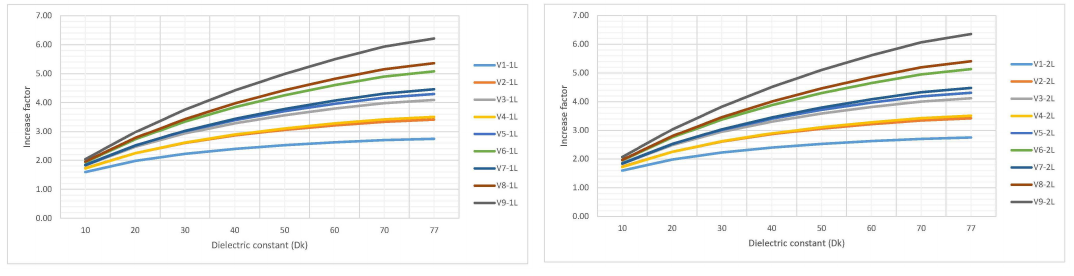
Figure 13. Simulation results of capacitance increase factor for the 18 structures when the (cid:101) r of the environment is swept from 1 to 77 with value (cid:101) r = 1 omitted from the Graph. The data from Table 1 is